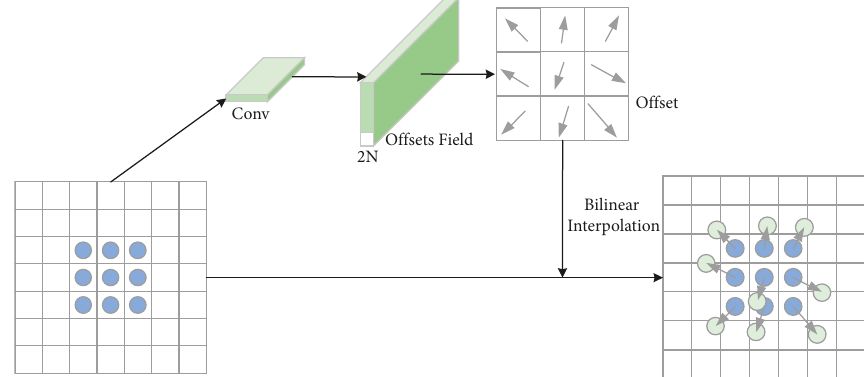
Figure 3: Structure of deformable convolutional network. The deformable convolutional layers were represented in this study by adding 18 output channels to a 2D convolution layer with a convolution kernel size of 3 × 3, a convolution step of 2 × 2, and a feature map padding of 1 as offsets before a 2D convolution layer with a convolution kernel size of 3 × 3, a convolution step of 2 × 2, and a feature map padding of 1.